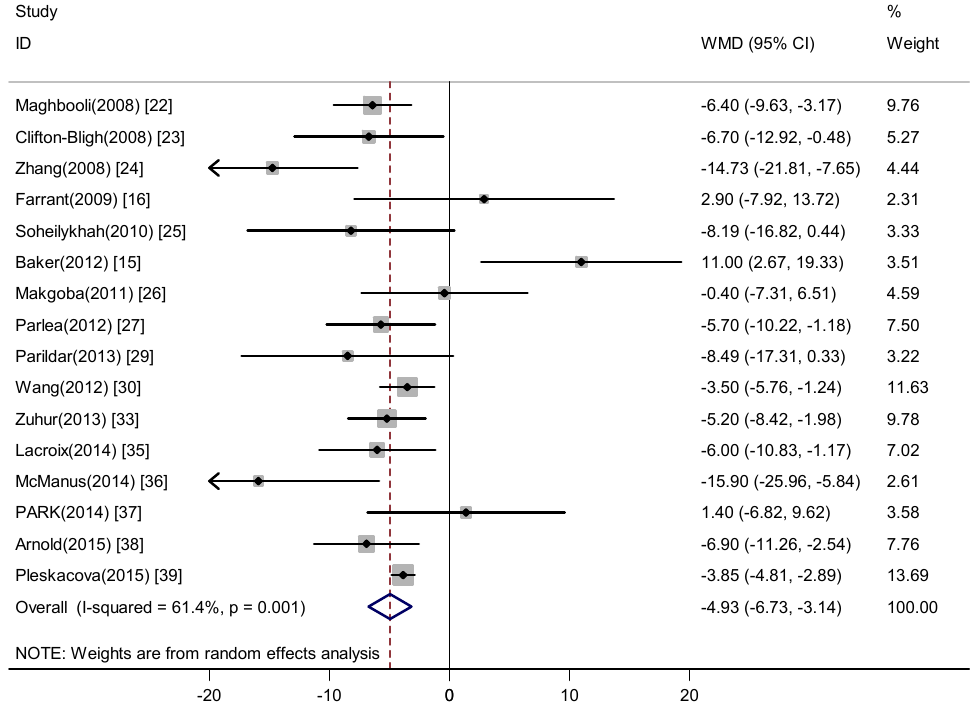
Figure 3. Meta ‐ analysis of the association between serum 25(OH)D level and GDM. Figure 3. Meta-analysis of the association between serum 25(OH)D level and